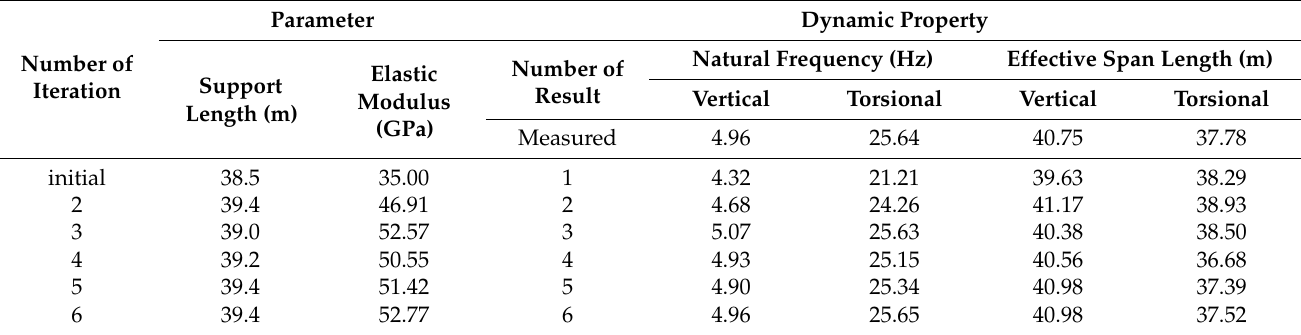
Table 5. Numerical model updating process of the Imgi 2nd